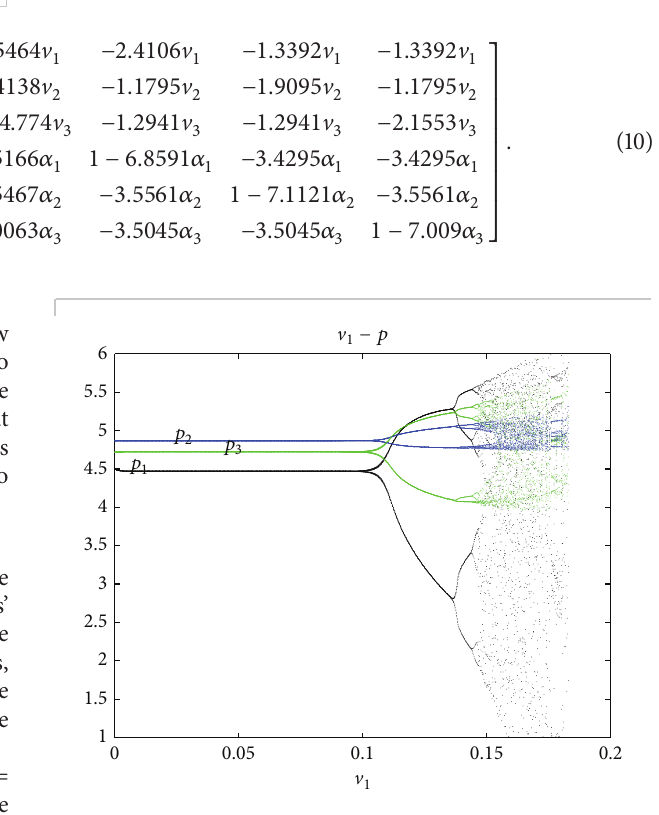
Figure 1: Price bifurcation with the change of V 1